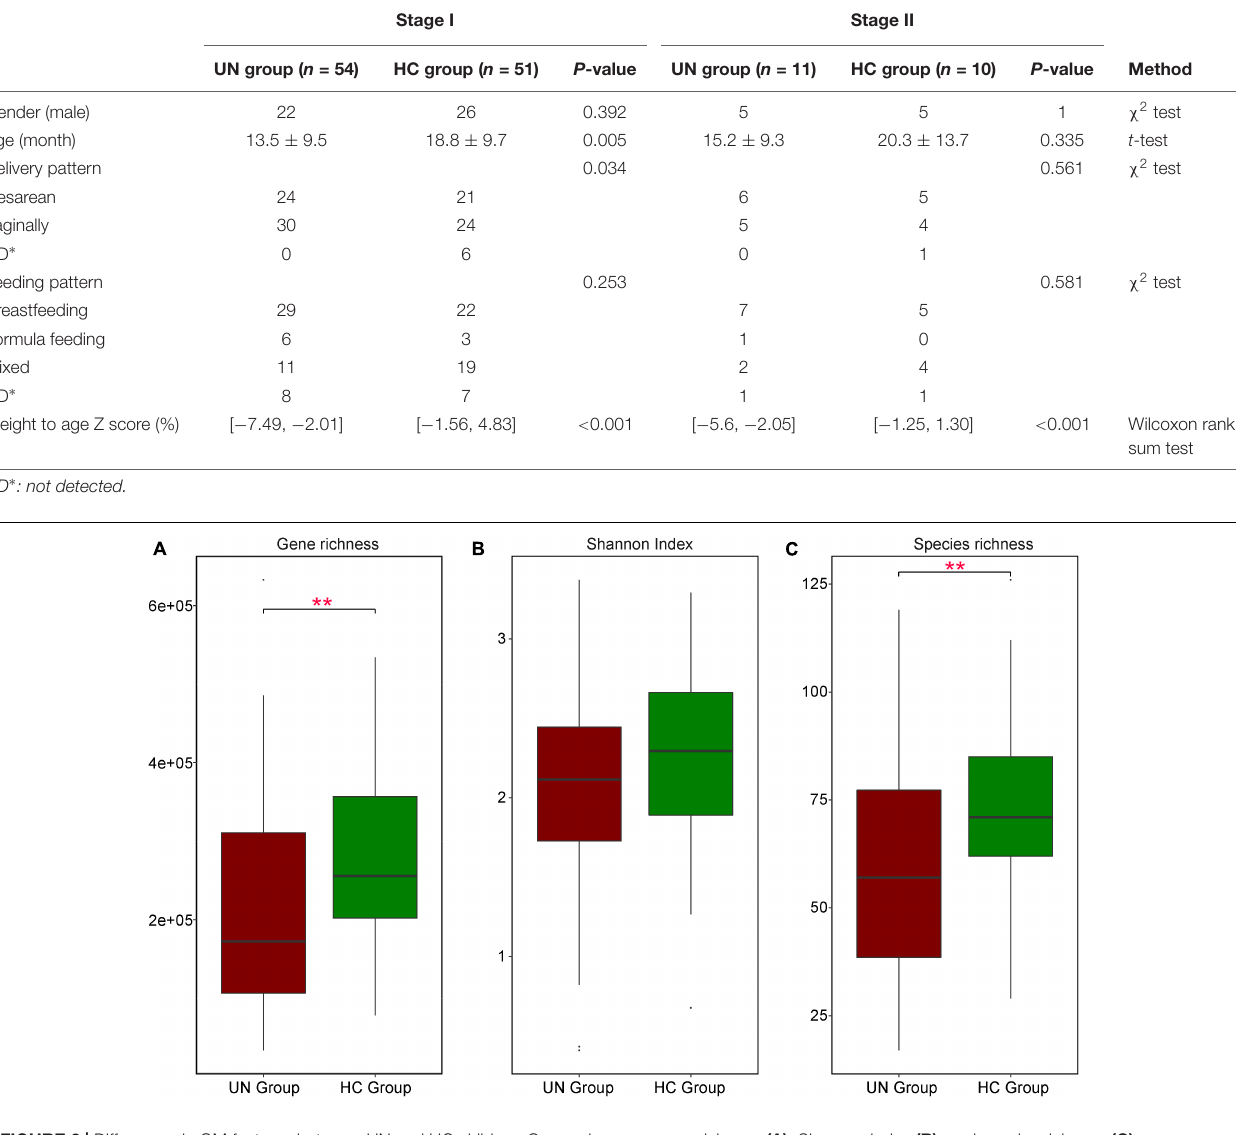
FIGURE 2 | Differences in GM features between UN and HC children. Comparisons on gene richness (A) , Shannon index (B) , and species richness (C) were executed between 54 UN patients and 51 HC children; their values in these two groups are represented by red and green boxes respectively. Significant differences are indicated with ∗∗ P <